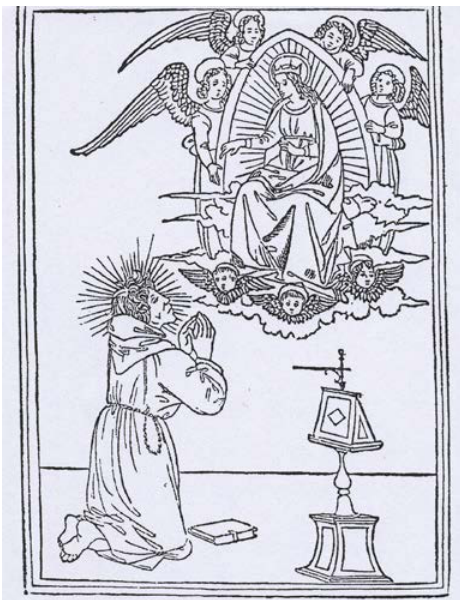
Figure 32 – Jacopone da Todi, Laudi , Firenze, Francesco Bonaccorsi, 28 September 1490, (from Kristeller 1897, n. 220, 86, cut 9), Cornell University Library, Public Domain, <https:// archive.org/details/cu31924029555574/page/n8)>